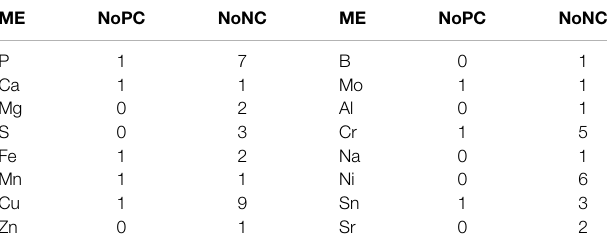
TABLE 5 | The total number of phenotypic traits linked with mineral elements content signi fi cance level of p 0.05 and p